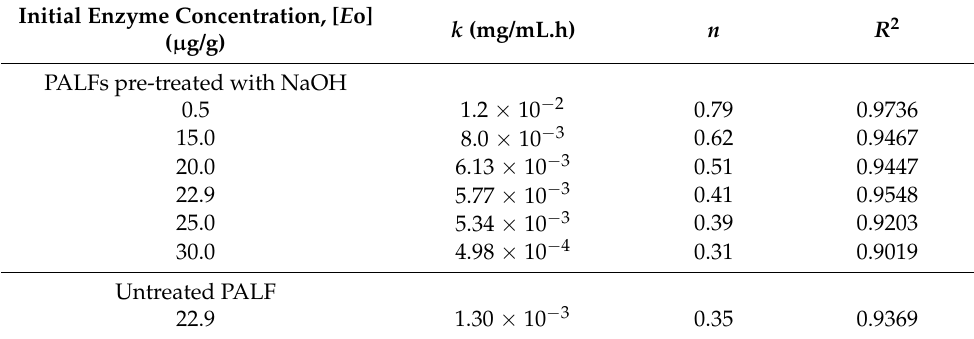
Table 4. Parameters based on empirical data regression.